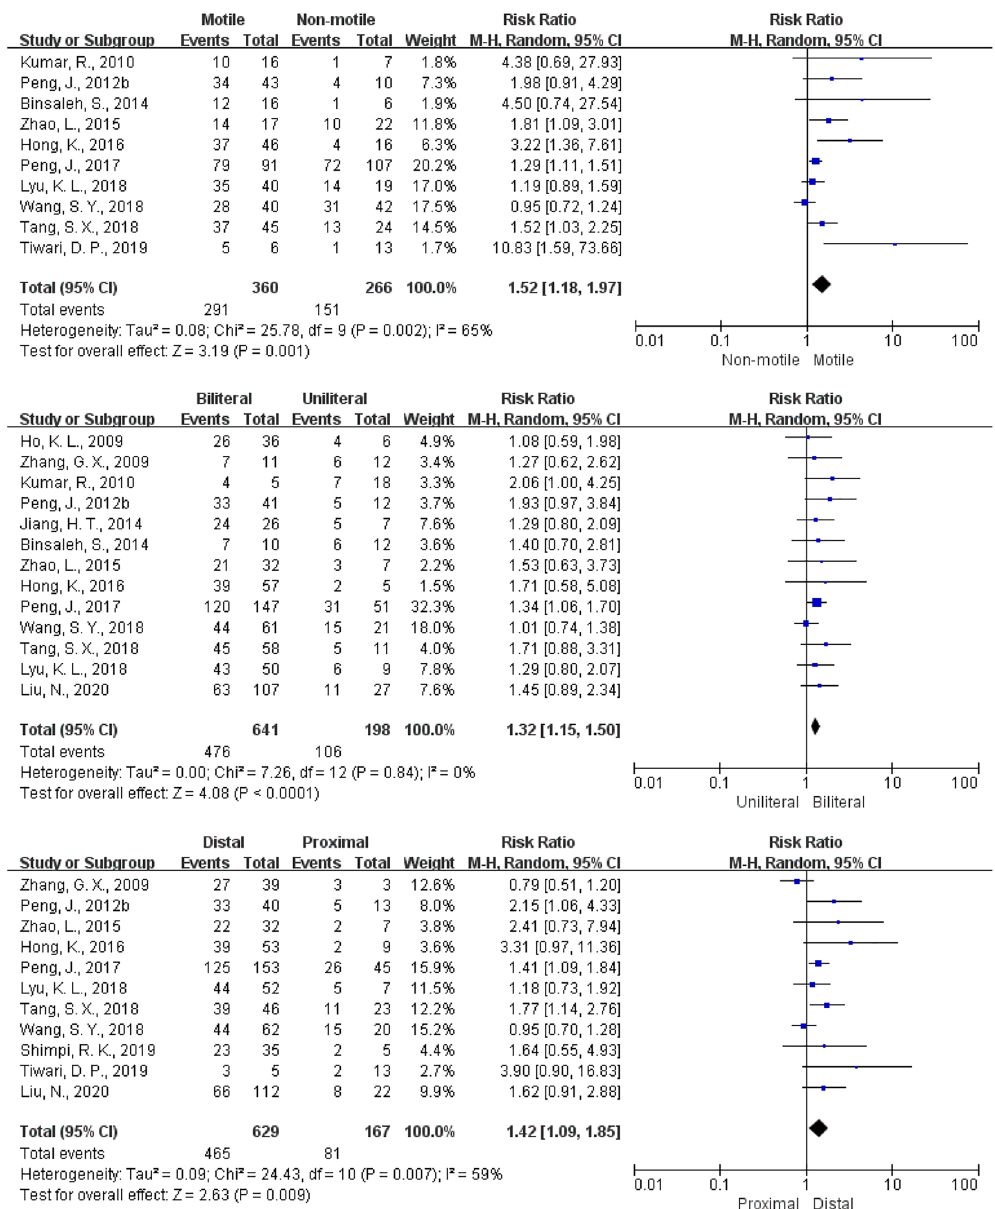
Figure 6. Forest plots of comparison of different factors affecting patency rate: the presence of motile vs. non-motile sperms found in epididymal fluid, anastomosis bilateral vs. unilateral, and anastomosing distal vs. proximal